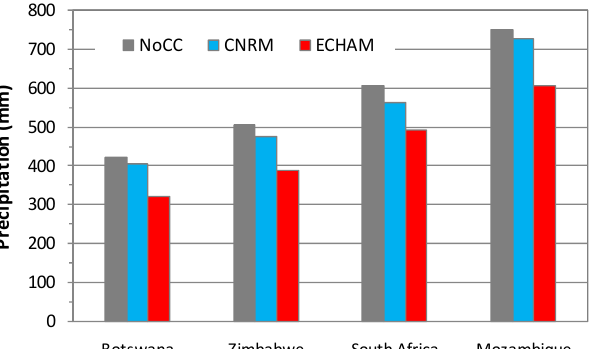
Figure 6. Mean annual precipitation under the 1971–2000 climate baseline and climate change scenarios for 2050.